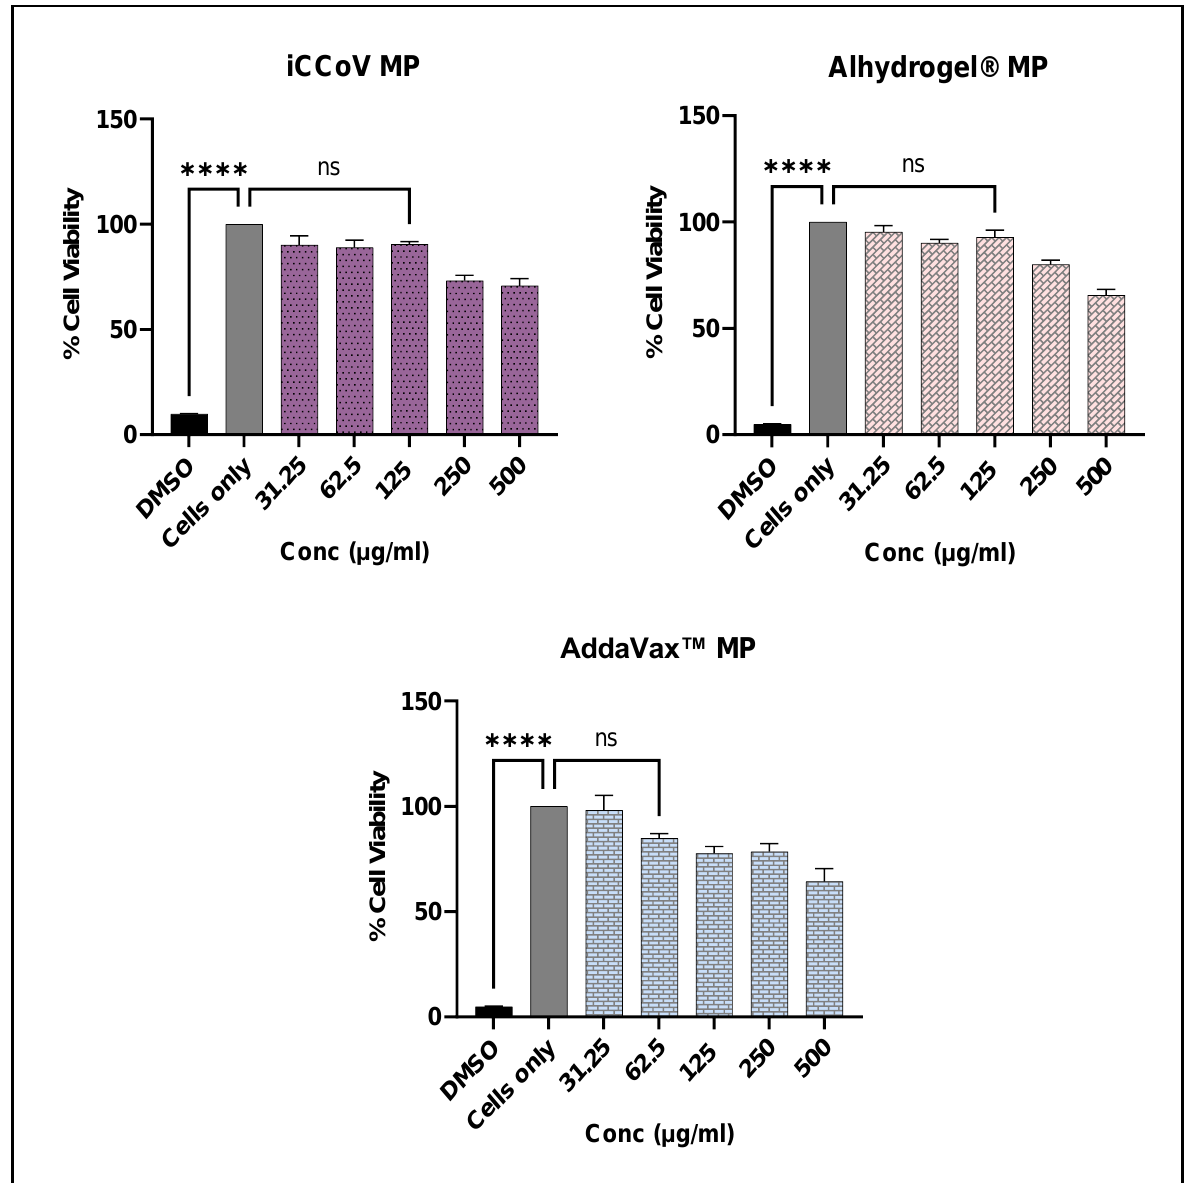
Figure 5. Percent Viability of DCs pulsed with varying concentrations of iCCoV MP, Alhydrogel ® MP, and AddaVax™ MP as measured using MTT assay. Cell density was adjusted to 1 × 10 4 cells/well. The cells were exposed to two-fold serial dilutions of the corresponding MP groups ranging from 31.25 ug/mL to 500 ug/mL in cDMEM (100 µ L/well) for 24 h. DMSO (50 µ L) was used as a -ve control, and cells only were used as a +ve control. Data are expressed as mean ± SEM ( n = 3). One- way ANOVA test, Post hoc Dunnett’s multiple comparison test, **** p ≤ 0.0001, ns, non -signif- icant.